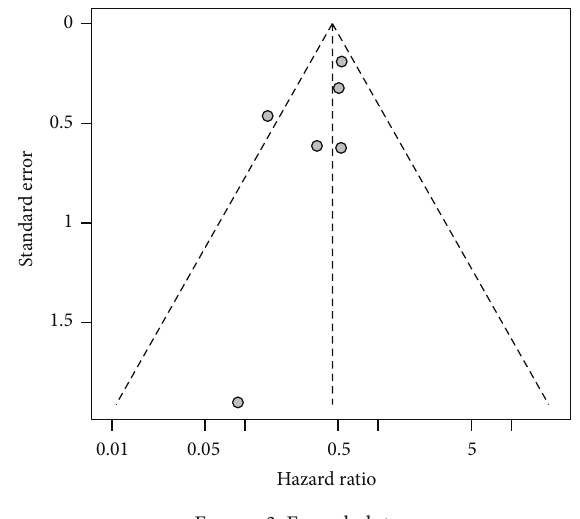
Figure 3: Funnel